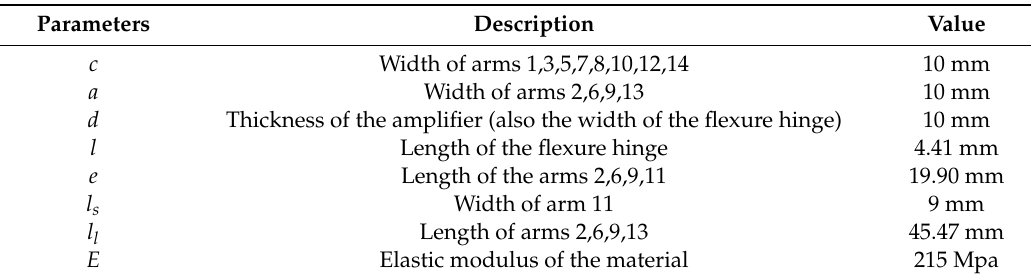
Table 1. Size of DBMA for simulation.